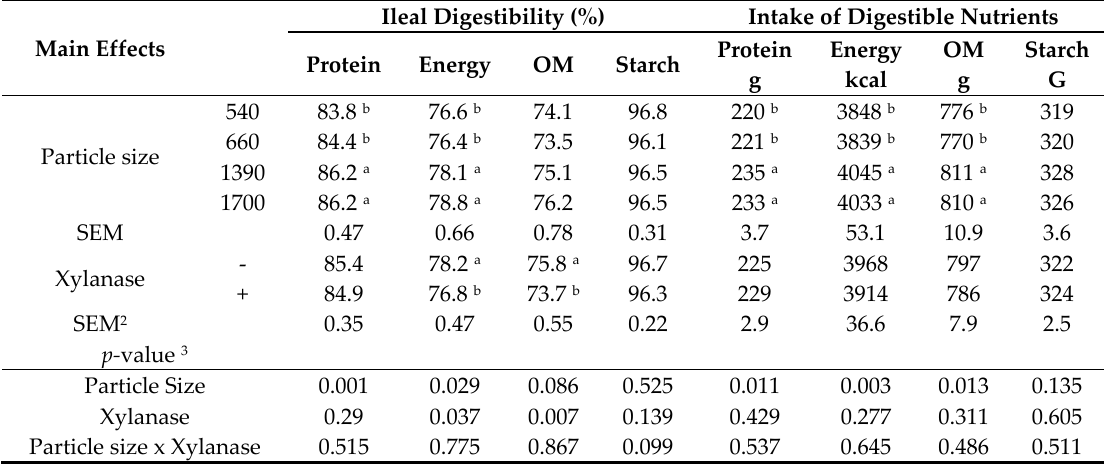
Table 6. Effects of particle size and xylanase inclusion on 21-day apparent ileal digestibility and intake of digestible nutrients 1,2 .